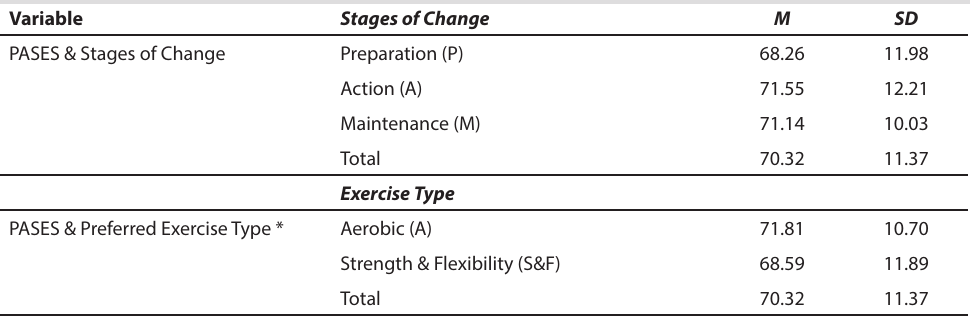
TABLE 1. Descriptive Statistics of PASSES by Stages of Change and Preferred Exercise